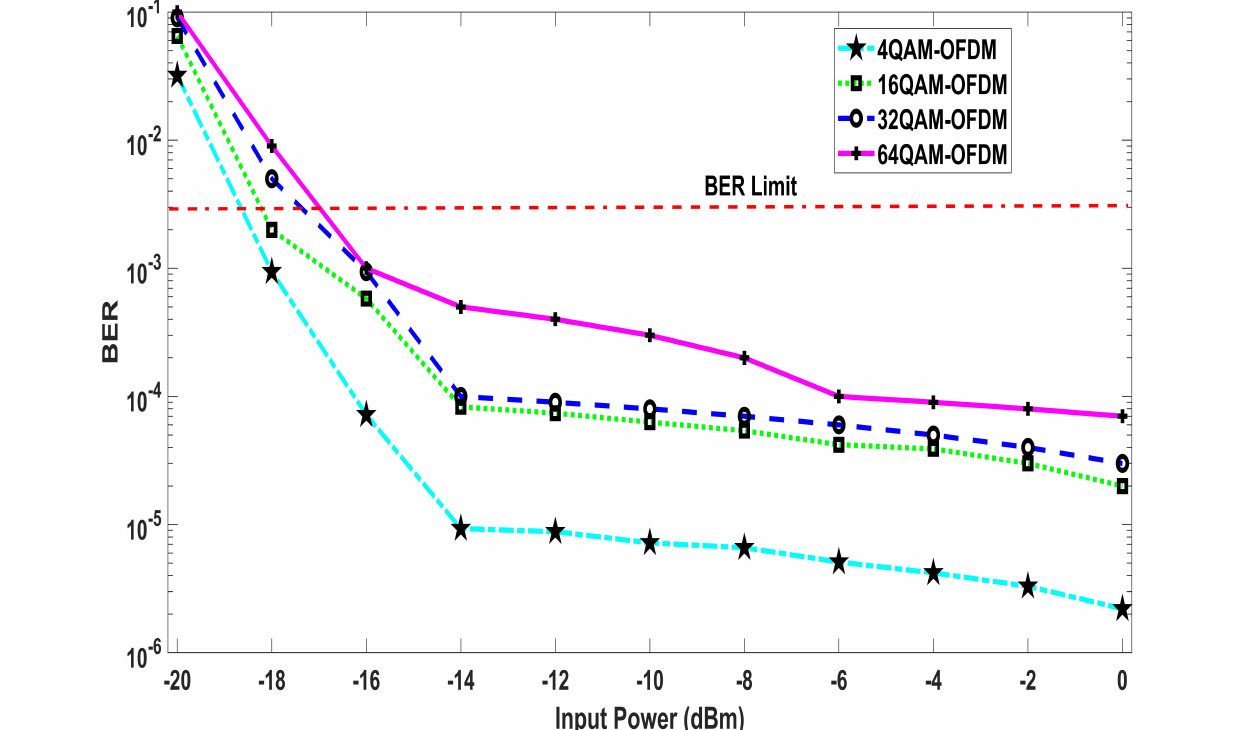
Figure 7. Analysis of different QAM-OFDM formats in terms of BER and input